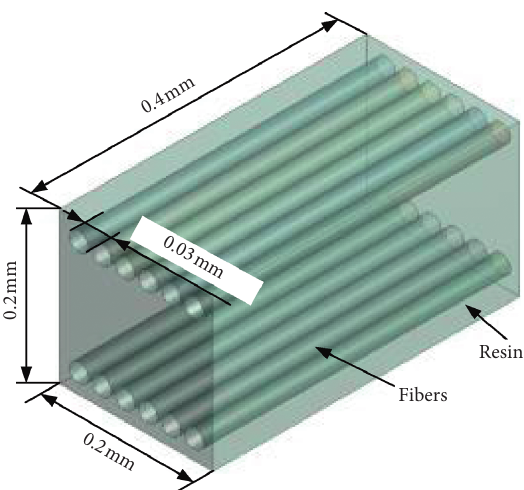
Figure 2: Fluid-solid coupling geometric